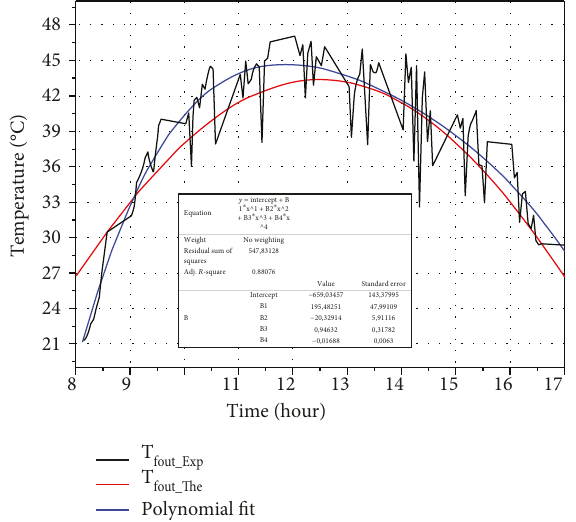
Figure 11: Validation of the mathematical